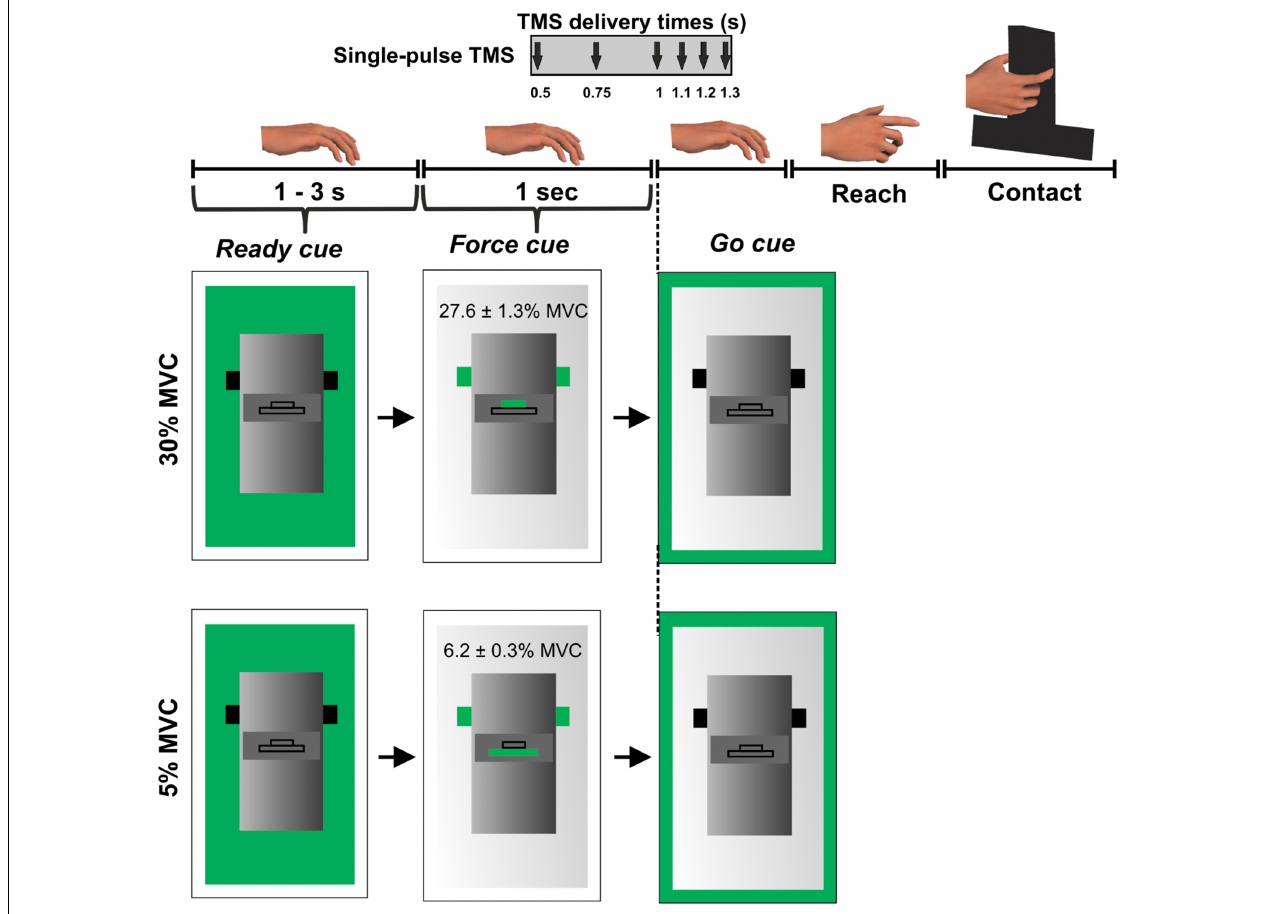
FIGURE 1 | Experimental protocol. Figure adapted from Parikh et al.